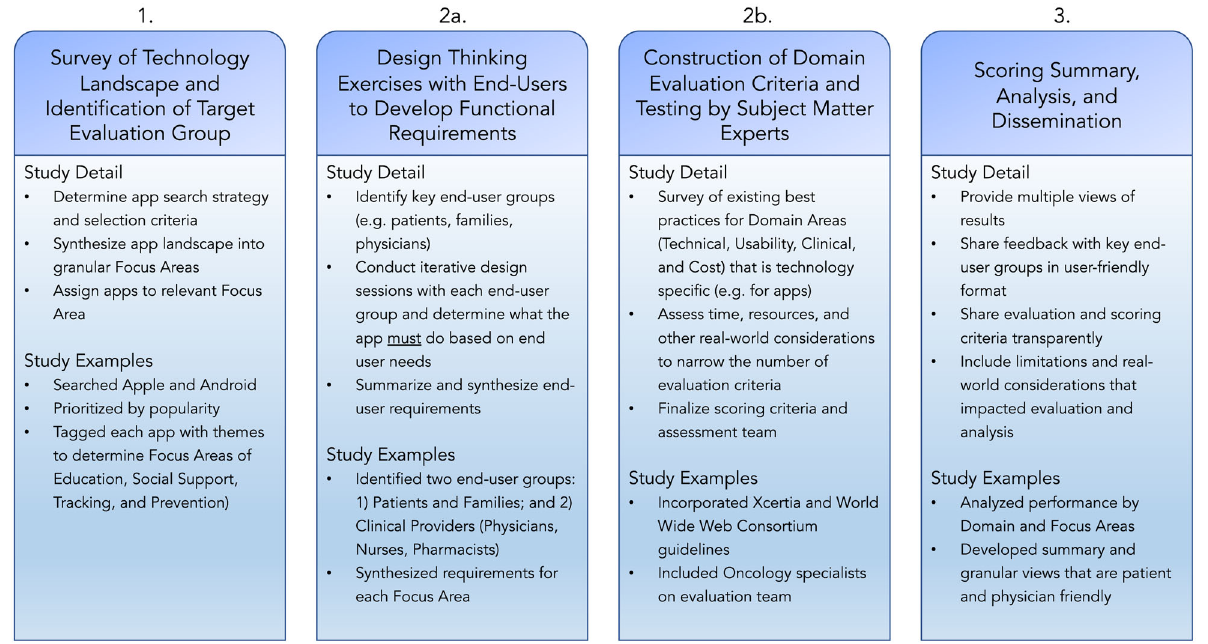
Fig. 8 Summary of digital health scorecard approach. Phases of evaluation are depicted, beginning with technology target assessment, followed by determination of requirements, development of assessment criteria, and fi nally, scoring and